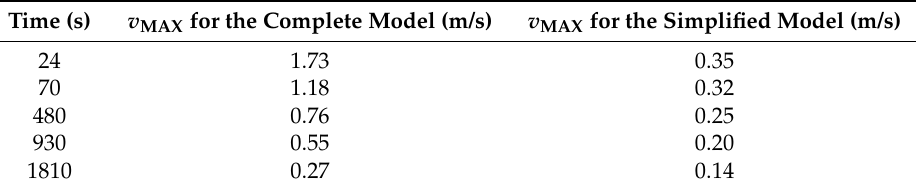
Table 1. Steel velocity on the free surface as a function of time.